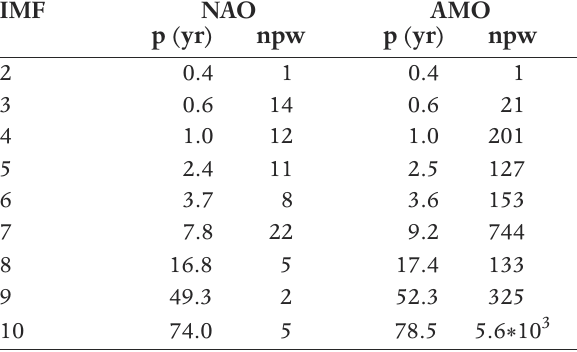
Table 2. Period (p, in year) and corresponding power (npw) result- ing from the Fourier transform for each IMF of NAO and AMO in- dices (npw is normalized by the power of IMF2). For the EEMD analysis, we set NE=300 for AMO and NE=400 for